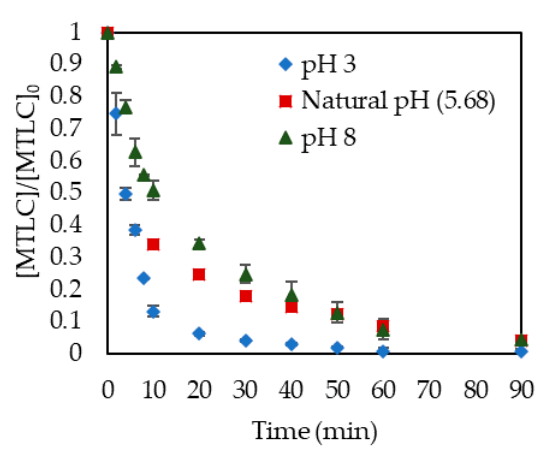
Figure 1. pH influence on S-Metolachlor degradation. Catalyst concentration: 0.5 g/L.